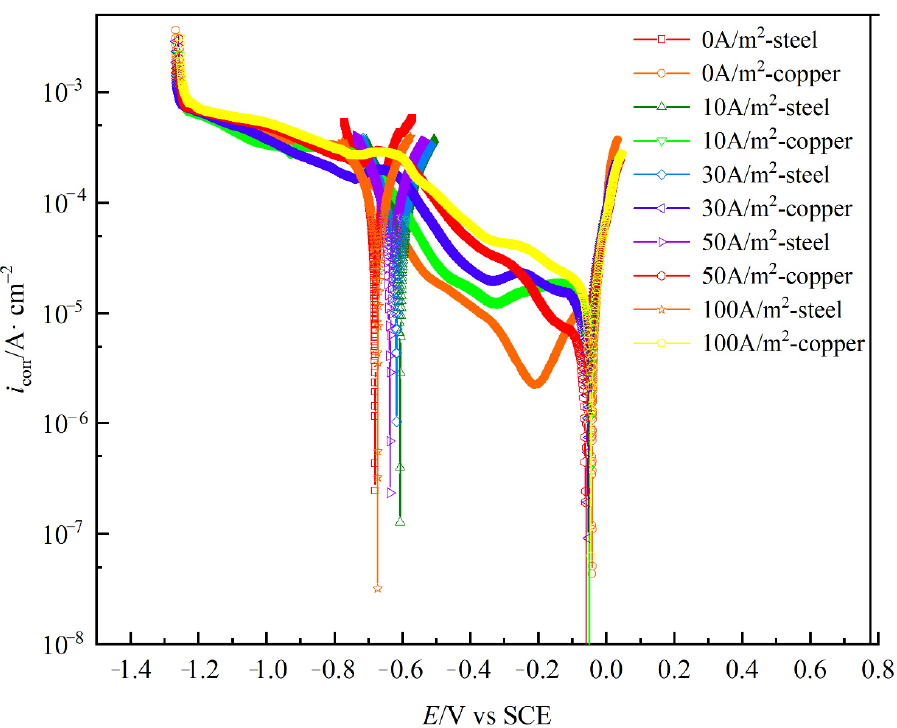
Figure 11. Potentiodynamic polarization curves for copper and steel electrodes with interference of AC intensities in simulated acidic soil solution. Table 4. Fitted results of potentiodynamic polarization curve for steel–copper with AC interference.